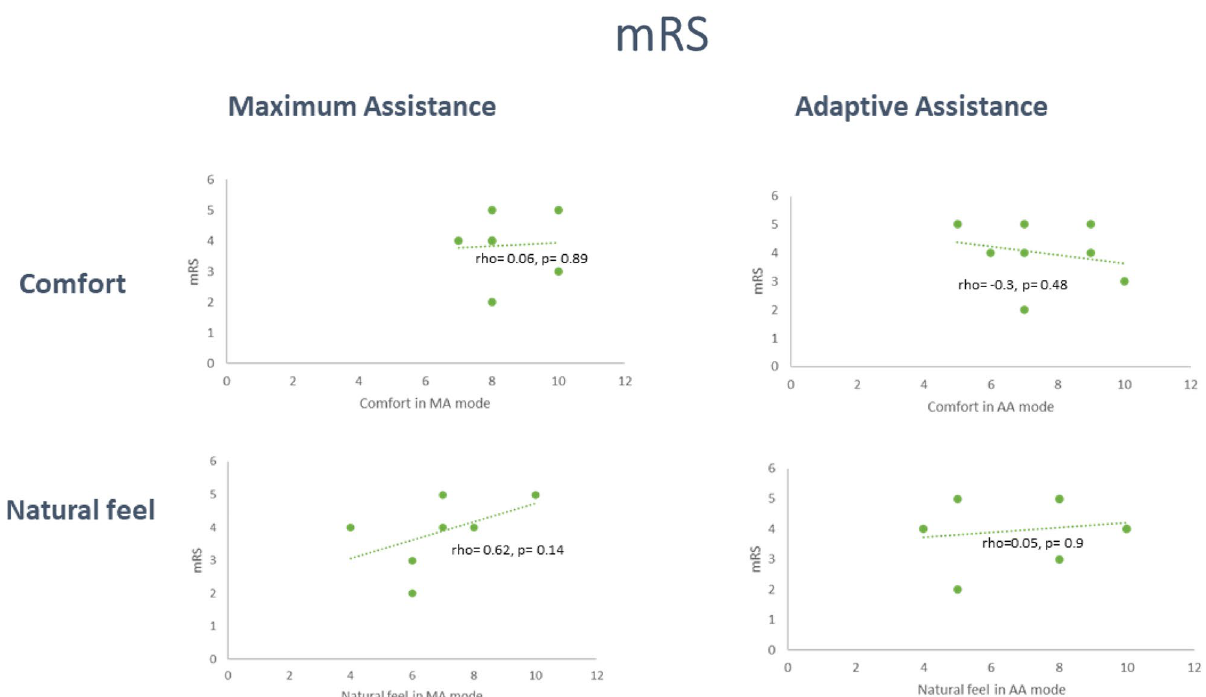
Figure 2. Correlation between mRS and Likert rating